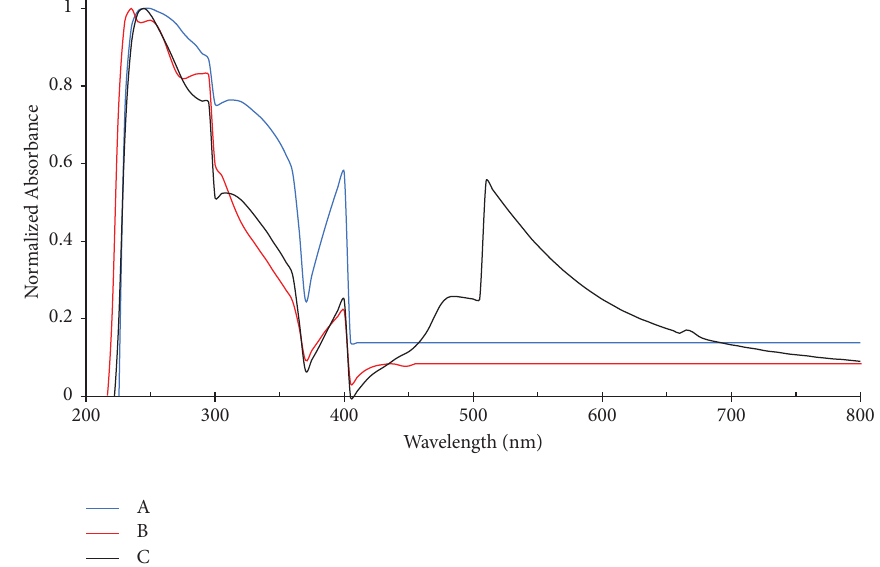
Figure 2: (a) Spectroscopy studies of quercetin (b) quercetin-zinc (c) and quercetin-iron.